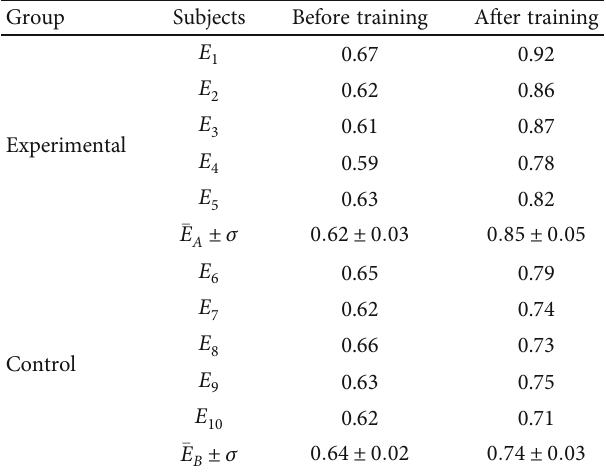
Table 2: The eigenvalue E of wrist fl exion motor imagery of 10 subjects before and after rehabilitation